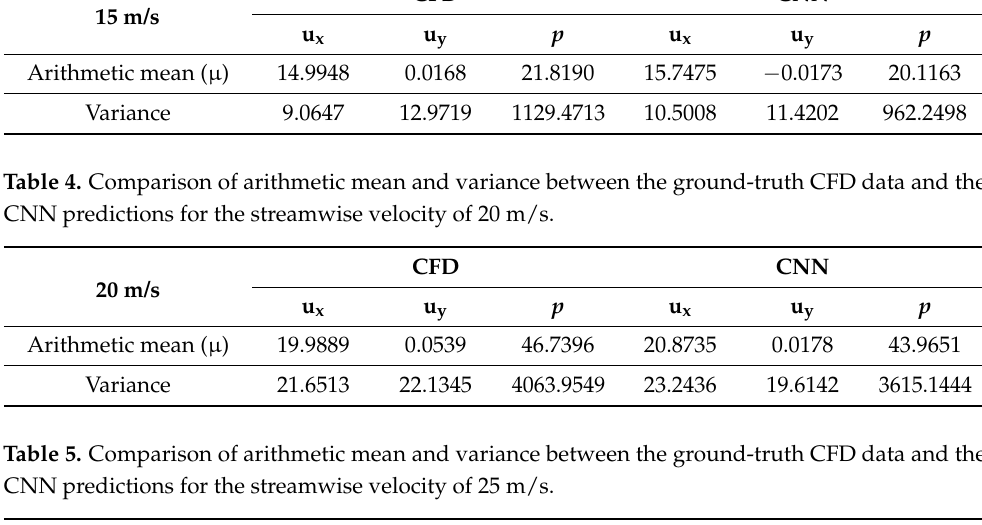
Table 3. Comparison of arithmetic mean and variance between the ground-truth CFD data and the CNN predictions for the streamwise velocity of 15 m/s.